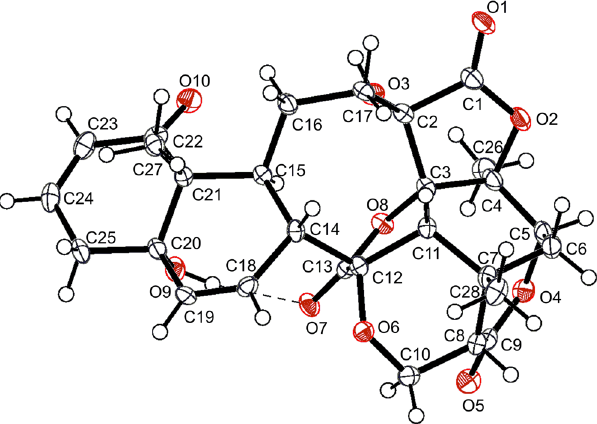
Figure 4. ORTEP drawing of compound 12